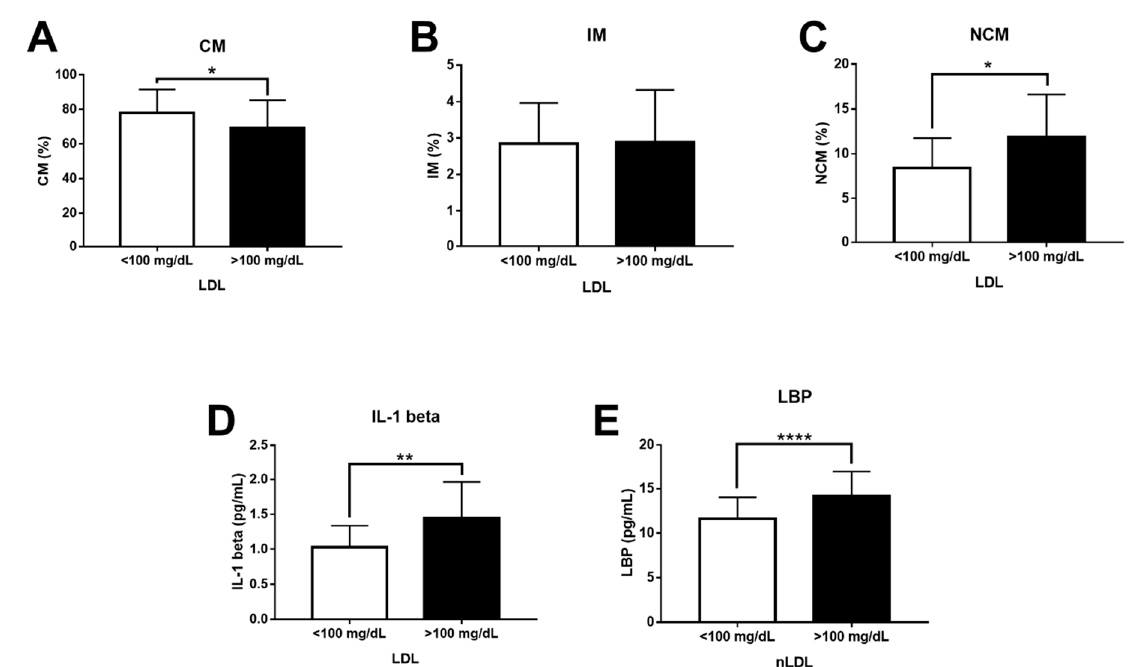
Figure 5. Levels of CMs, IMs, NCMs, IL-1 beta, and LBP in subjects with optimal and high serum levels of LDL-C. ( A ) The CM percentage significantly decreased in patients with serum LDL-C > 100 mg/dL (n = 85) as compared to controls (n = 65). ( B ) There were no significant changes between subjects with optimal and high LDL-C concentration for the IM percentage. ( C ) The NCM percentage significantly increased in patients with serum LDL-C > 100 mg/dL as compared to controls. ( D ) IL-1 beta serum levels significantly increased in patients with serum LDL-C > 100 mg/dL as compared to controls. ( E ) LBP serum levels significantly increased in patients with serum LDL-C > 100 mg/dL as compared to controls. Data are expressed as mean ± standard deviation. Data were compared using the unpaired Student’s t -test. Differences were considered significant when p < 0.05. * = p < 0.05; ** = p < 0.01; **** = p < 0.0001. CM, classical monocytes; IM, intermediate monocytes; NCM, non-classical monocytes; IL-1 beta, interleukin 1 beta; LBP, LPS-binding protein; LDL-C, low-density lipoproteins.